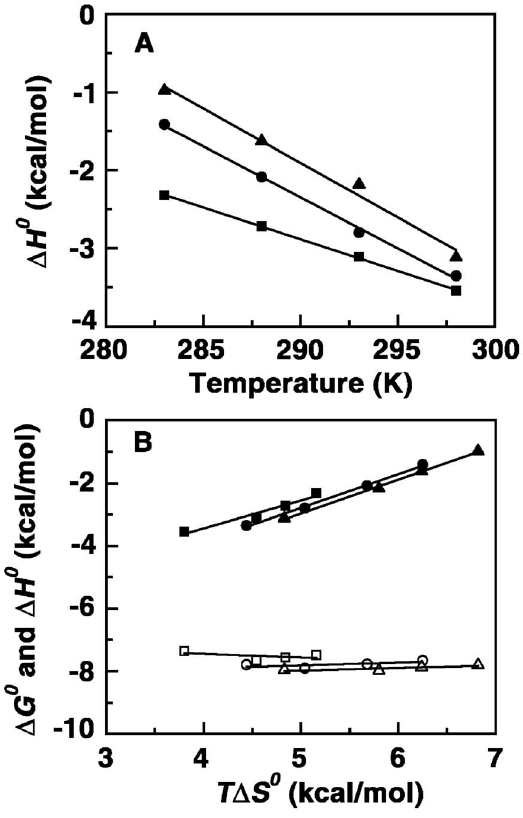
Figure 8. Plots of variation of temperature dependent thermodynamic parameters. (A) Plot of variation of enthalpy of binding ( D H 0 ) with temperature for binding of analog B2 ( & ), B3 ( and B4 ( m ) to tRNA. (B) Plot of variation of D G 0 (open symbols) and D H 0 (closed symbols) versus T D S 0 for the binding of analogs B2 ( & ), B3 ( and B4 ( m ) to tRNA, respectively.